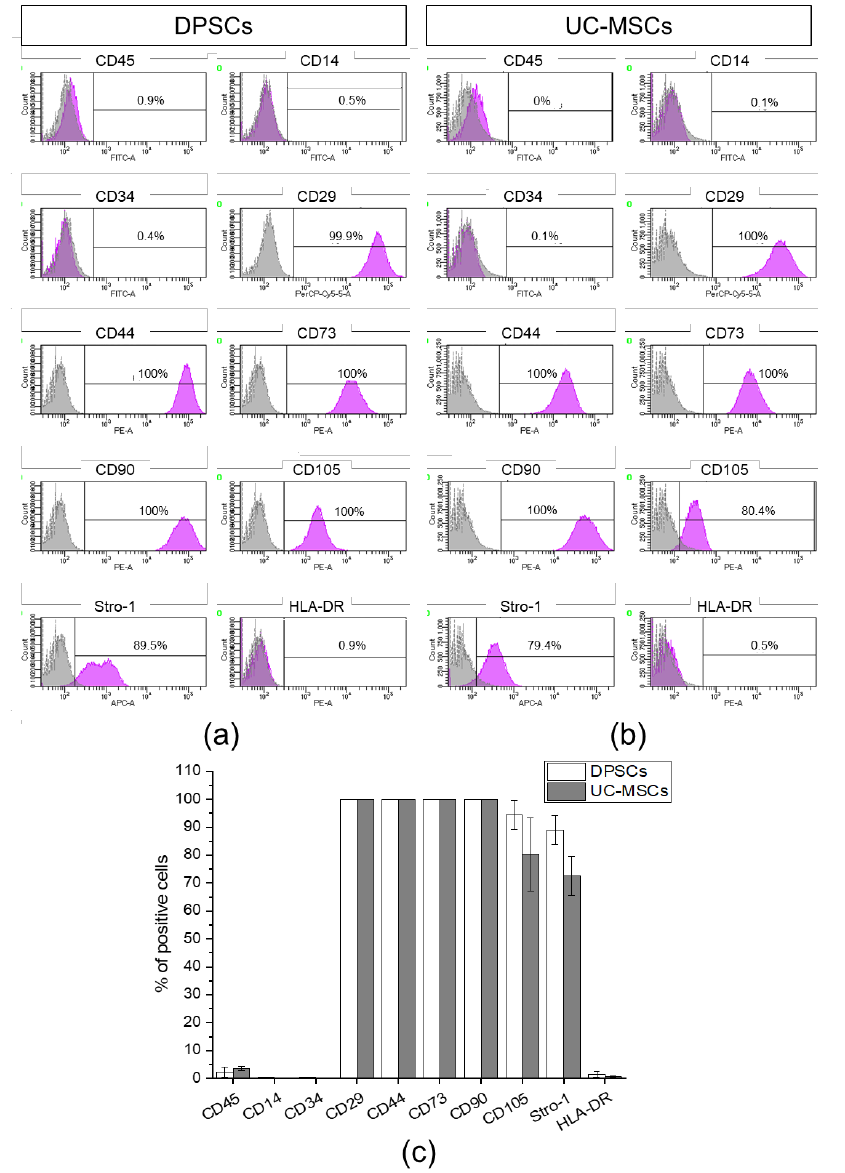
Figure 2. Antigenic profile of DPSCs and UC-MSCs with flow cytometry. Expression of MSC-negative markers (D45, CD14, CD34), MSC- positive markers (CD29, CD44, CD73, CD90, CD105, Stro-1), and HLA-DR antigen on DPSCs and UC-MSCs. ( a ) Representative histograms of the expression of